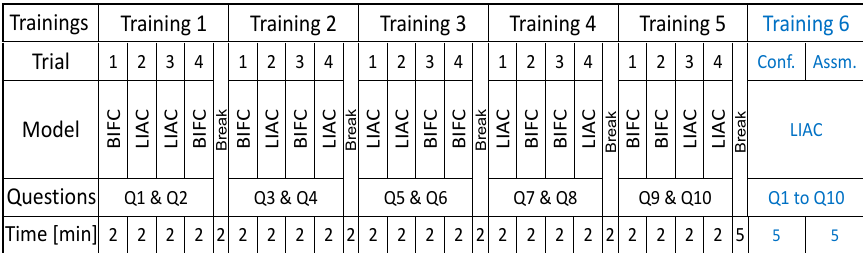
Figure 5. Experimental protocol. Training 1 to 5 were run in the first part of the experiment. Training 6 was run in the second part. Conf. and Assm. stand for Configuration and Assessment,